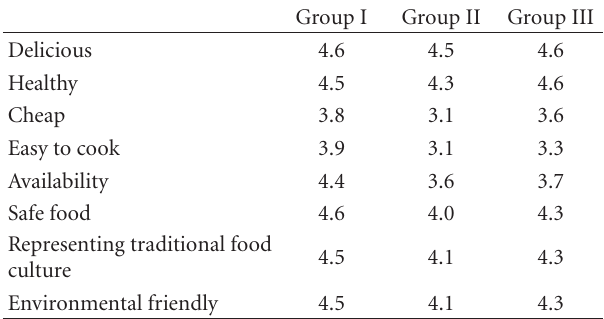
Table 7: Respondents’ attitude toward edible wild